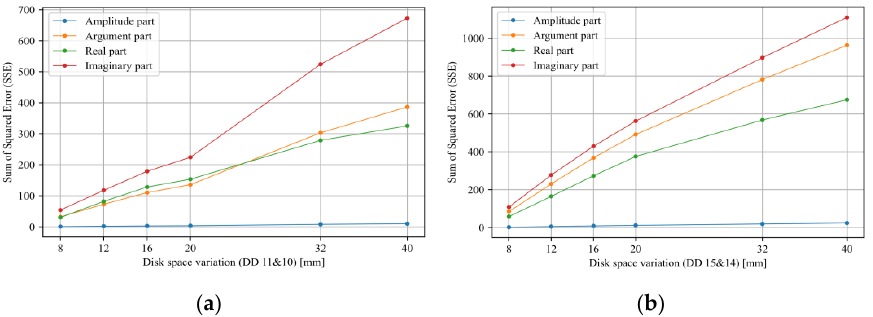
Figure 18. Feature variations based on the severity of the DSV fault in different locations for extracted by the SSE index: ( a ) DSV in DD 11 and 10 ( b ) DSV in DD 15 and 14.